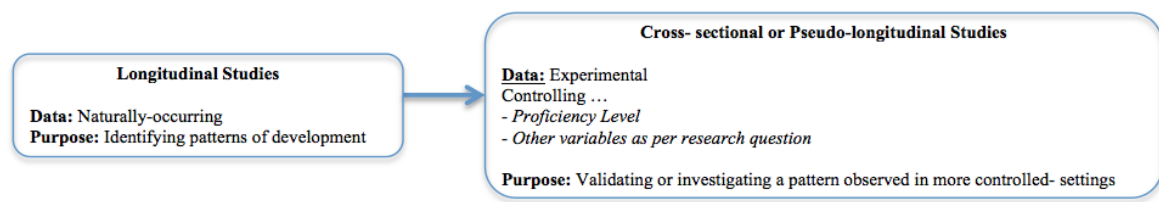
Proposed Research Agenda for L2 Pragmatic